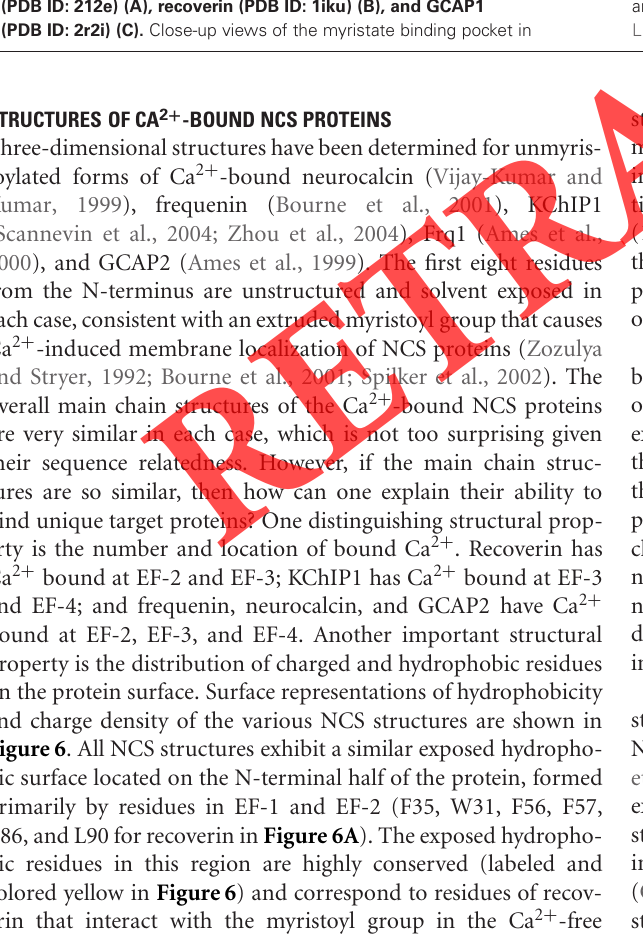
FIGURE 5 | Main chain structures of Ca 2 + -free myrisoylated NCS1 (PDB ID: 212e) (A), recoverin (PDB ID: 1iku) (B), and GCAP1 (PDB ID: 2r2i) (C). Close-up views of the myristate binding pocket in